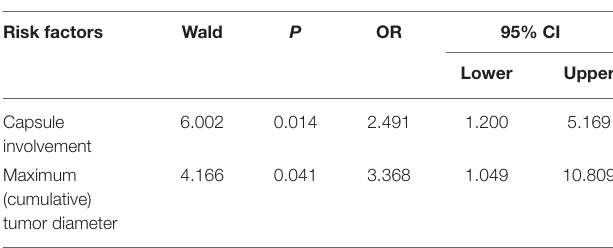
TABLE 3 | Multivariate analysis of CNM.